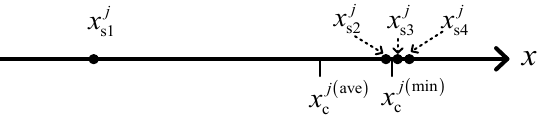
Figure 3. General design variable distribution.